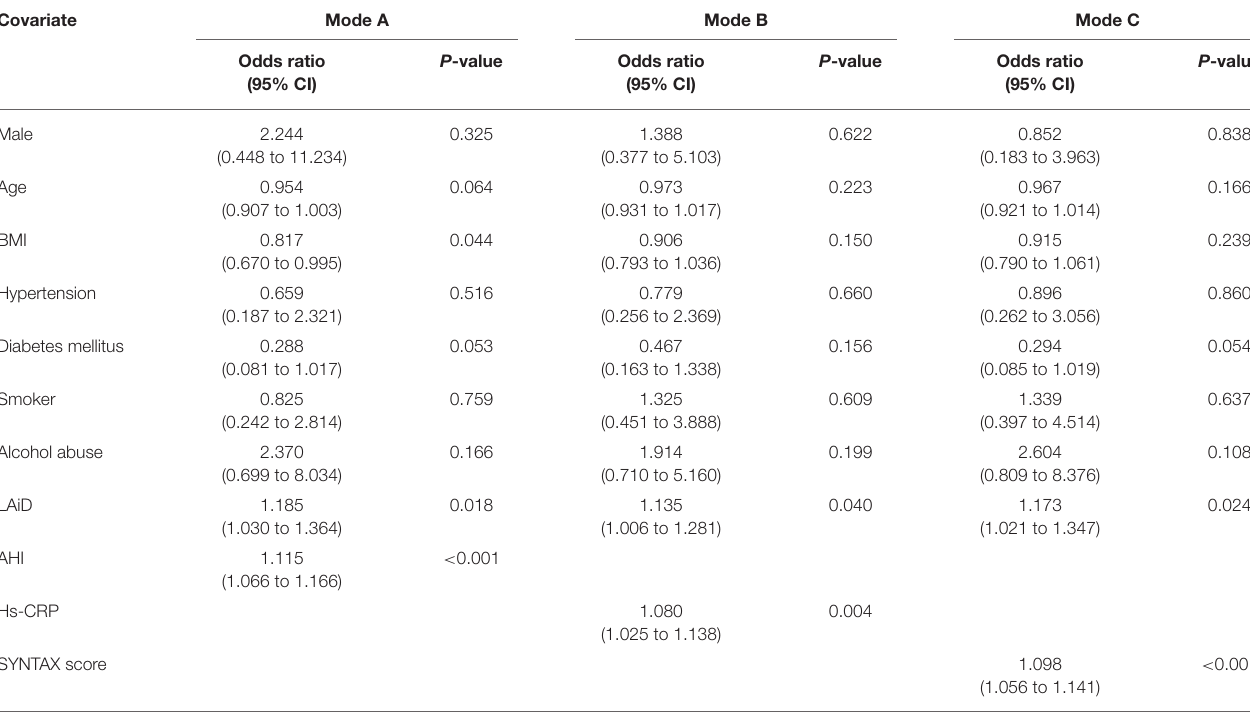
TABLE 5 | Multivariate logistic regression analysis for the correlation between various indicators and PMI. Covariate